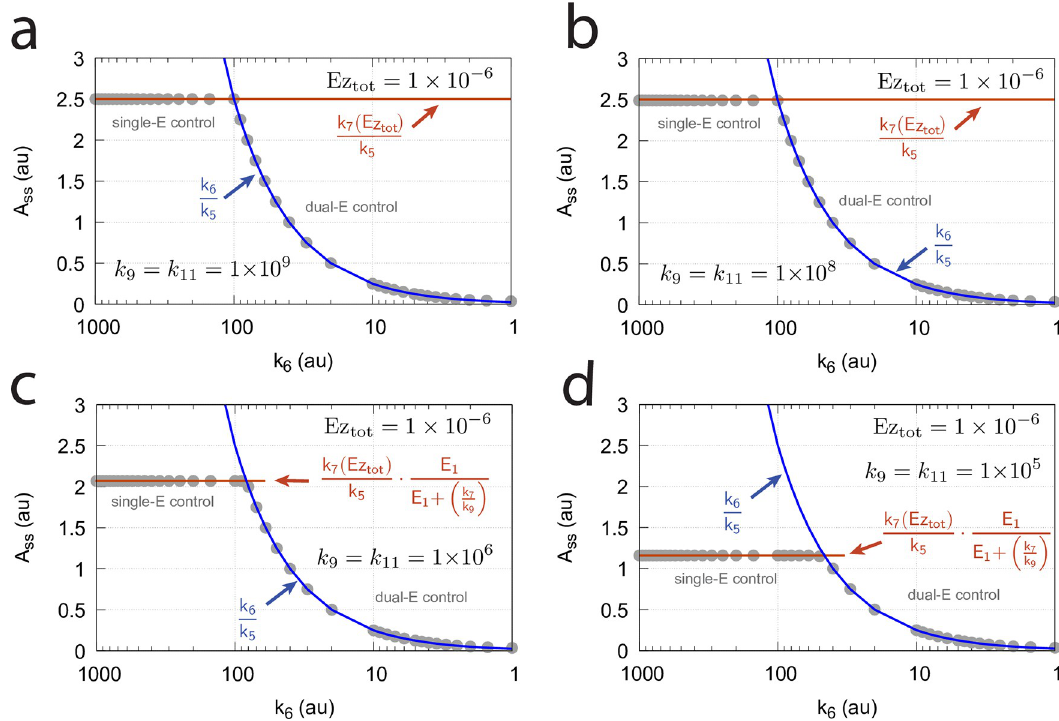
of the single- set of the single-E controller is described by Eq 113 with E 1 =4.82 × ss =1.16 (Eq 113). Other ss